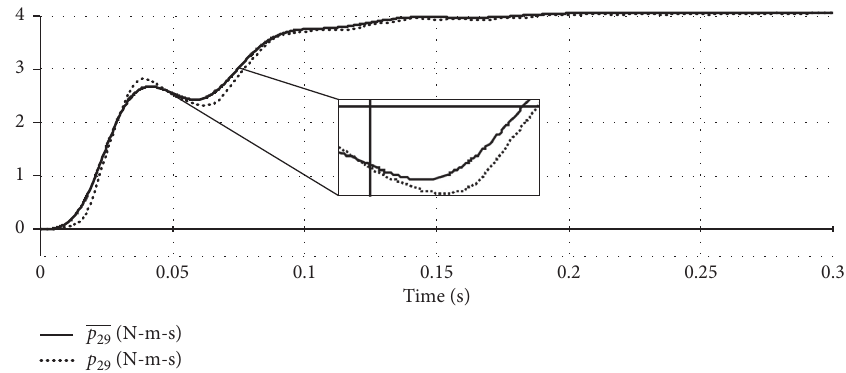
Figure 9: Performance of the slow variable p